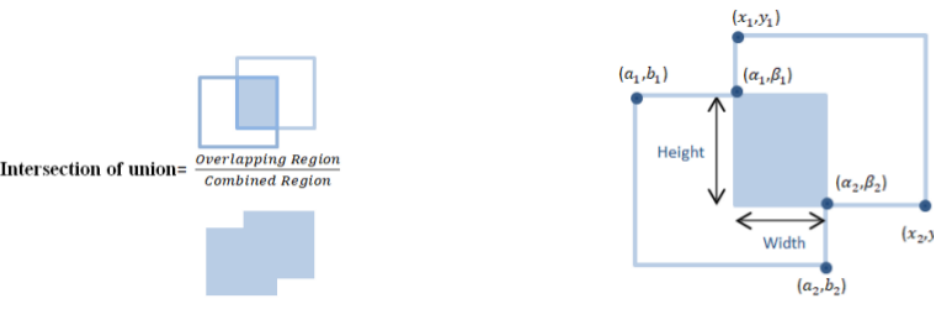
Figure 6. Intersection of Union on overlapped